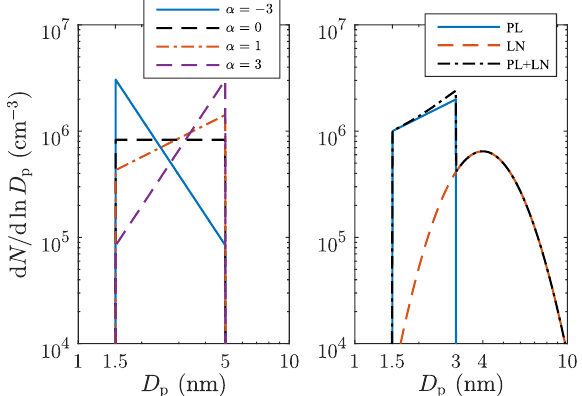
Figure 1. Left pane shows examples of power law distributions with different values of the slope parameter α . Right pane shows the combination of a power law (PL) and a log-normal (LN) distri- bution (PL + LN).